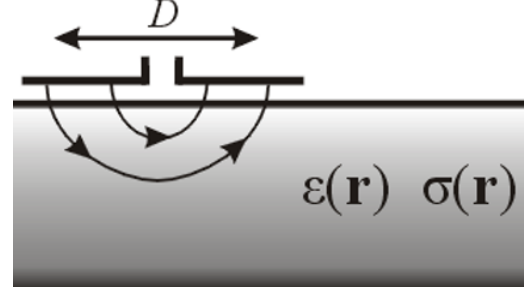
Fig. 1. Scheme of the stud of dieectric characteristics of the object